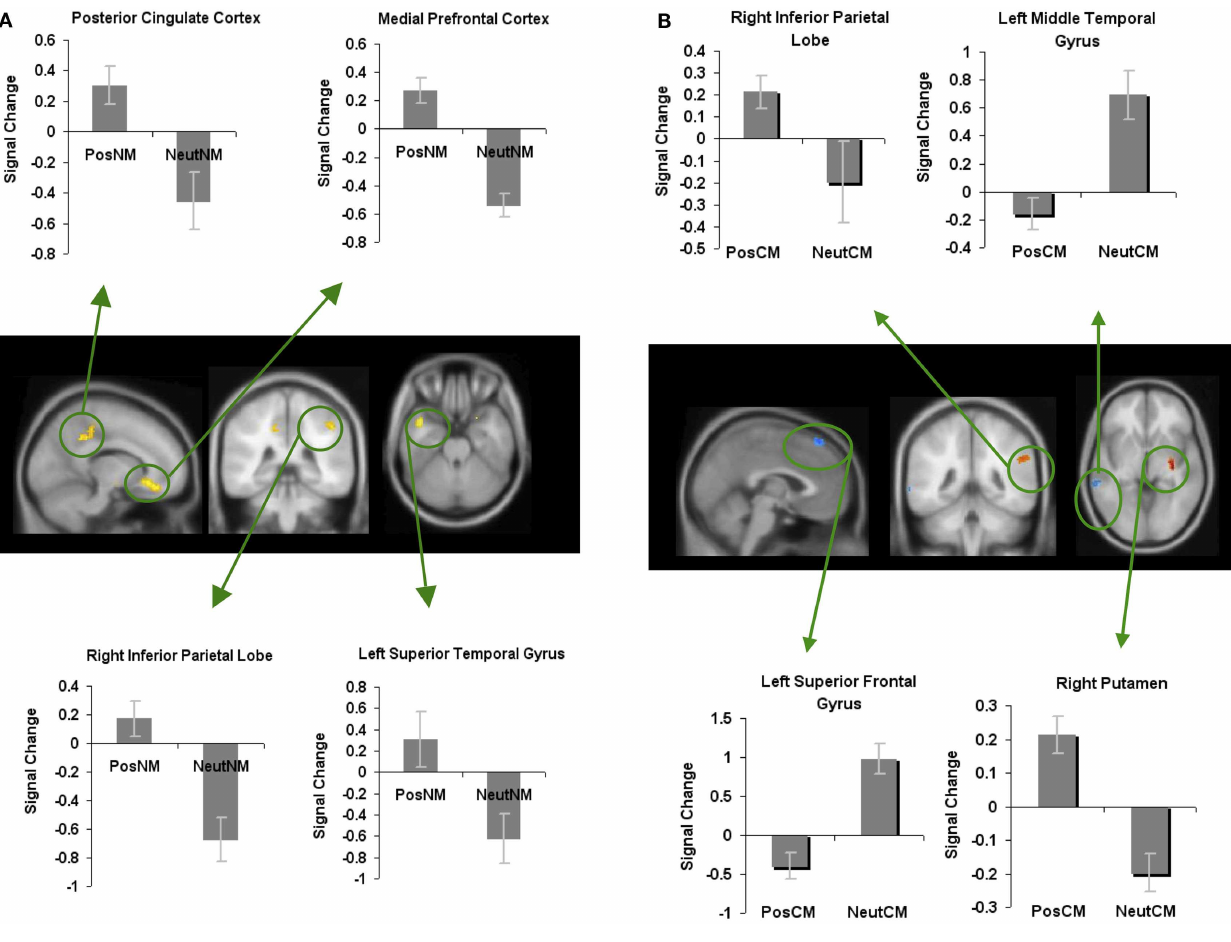
FIGURE 4 |Whole-brain activation showing signal change for the positively valenced versus neutral metaphoric type-specific contrasts: (A) reveals signal change for positively valenced novel metaphors versus neutral novel metaphors and (B) reveals signal change for positively valenced conventional metaphors versus neutral